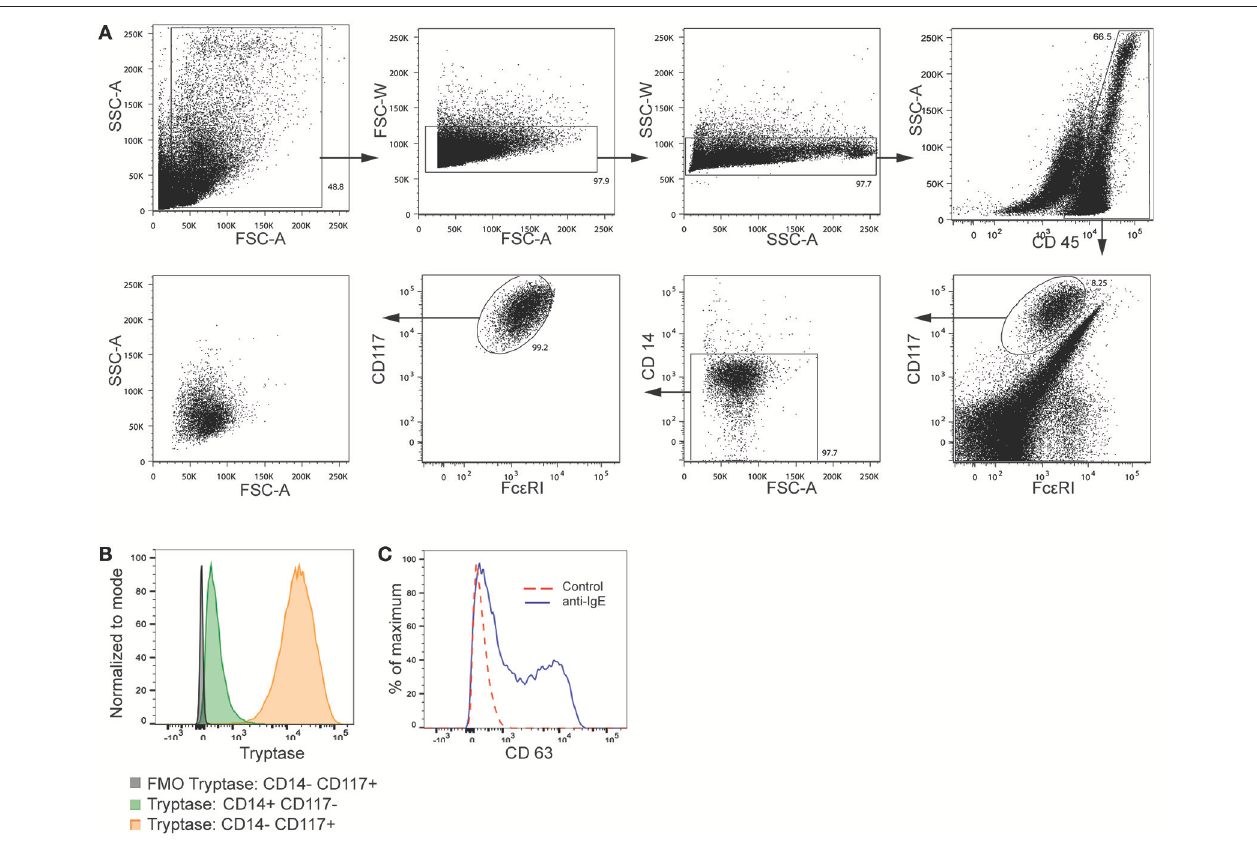
FIGURE 2 | Gating strategy for mast cells from human lung tissue. (A) CD117 high mast cells from human lung single cell suspension was identified using flow cytometry. (B) CD117 high mast cells and CD14 + cells were analyzed for intracellular Tryptase using flow cytometry. (C) Human lung mast cells cultured for 4 days, activated by Fc ε RI crosslinking and CD63 expression analyzed by flow cytometry. FSC, forward scatter; SSC, side